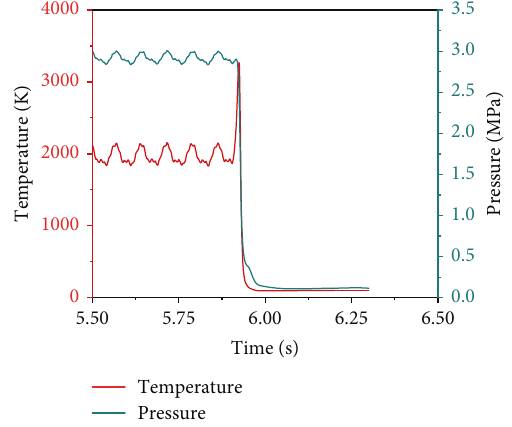
Figure 13: Shutdown process in pretest condition.